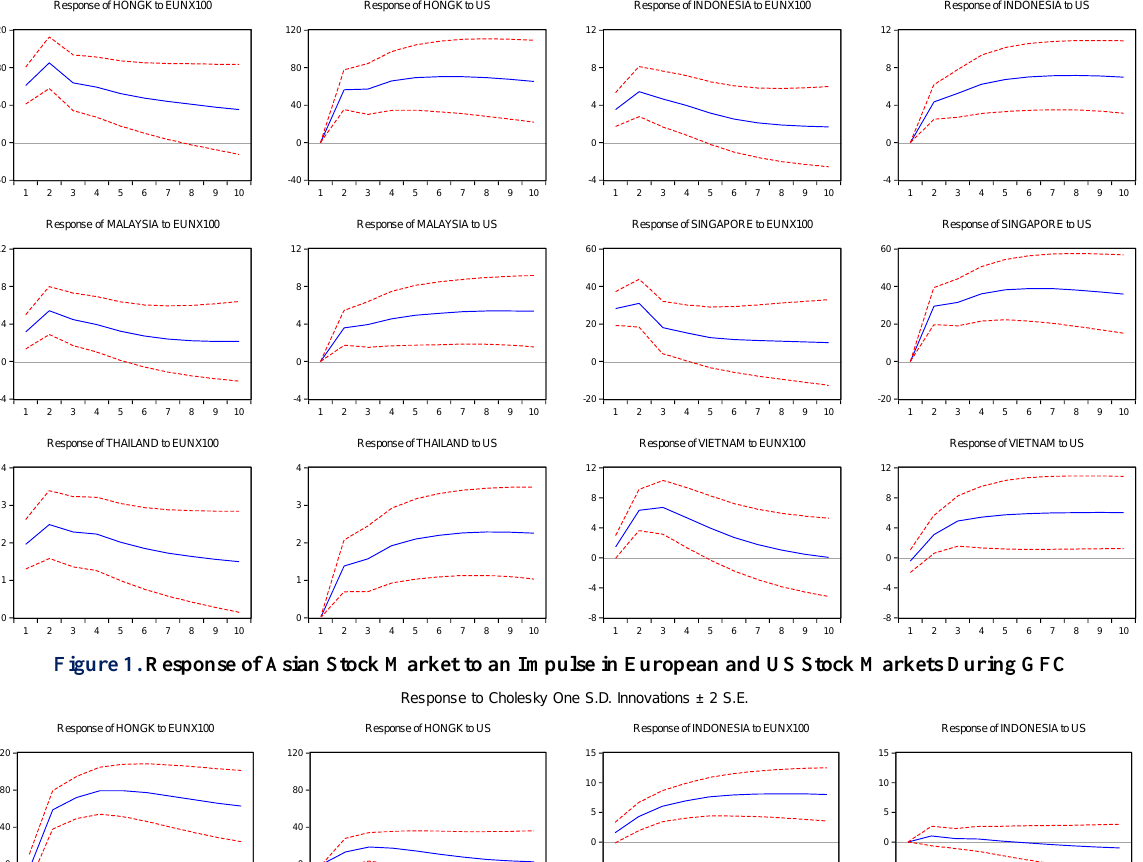
Figure 1. Response of Asian Stock Market to an Impulse in European and US Stock Markets During GFC